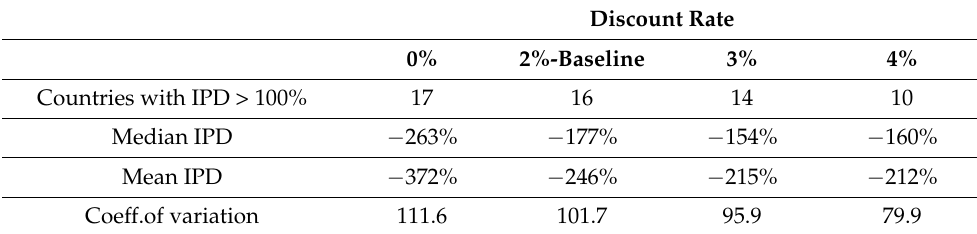
Table 4. The impact of the discount rate—number of countries with IPD > 100%.